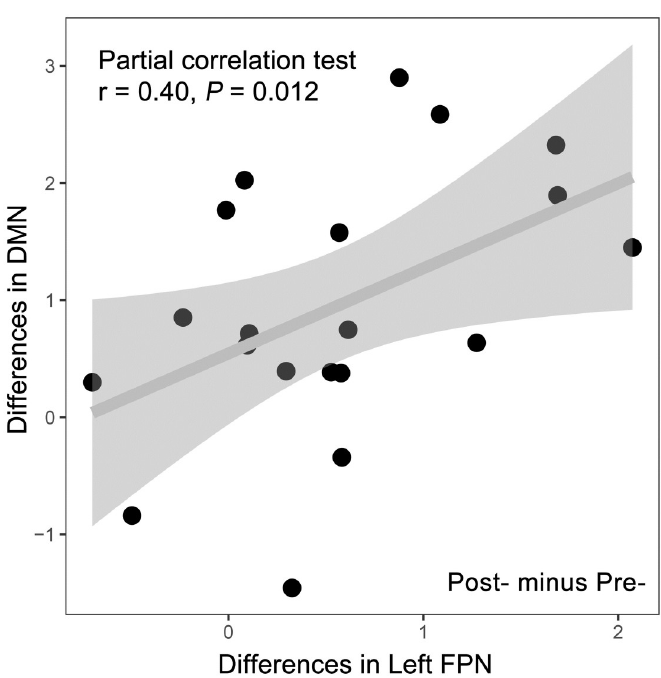
Fig 6. The result of the partial correlation test in the CFS patient group. The result of the partial correlation test between changes of the left frontoparietal network and the default mode network in the CFS group. All the changes and differences were calculated by post- minus